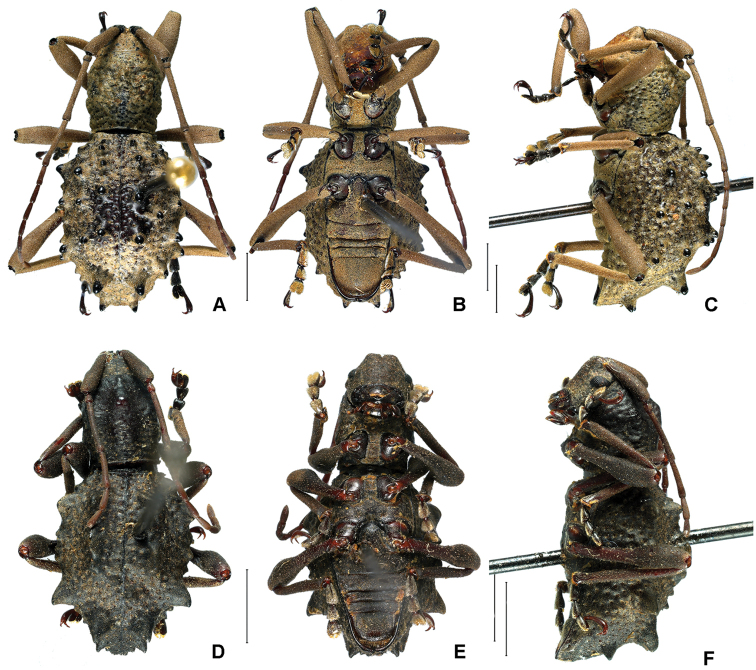
Dorsal, ventral and lateral view of two species of PhrynidiusA–CPhrynidius
jonesi sp. nov., holotype male D–FPhrynidius
tuberculatus sp. nov., holotype male. Scale bars: 2 mm.